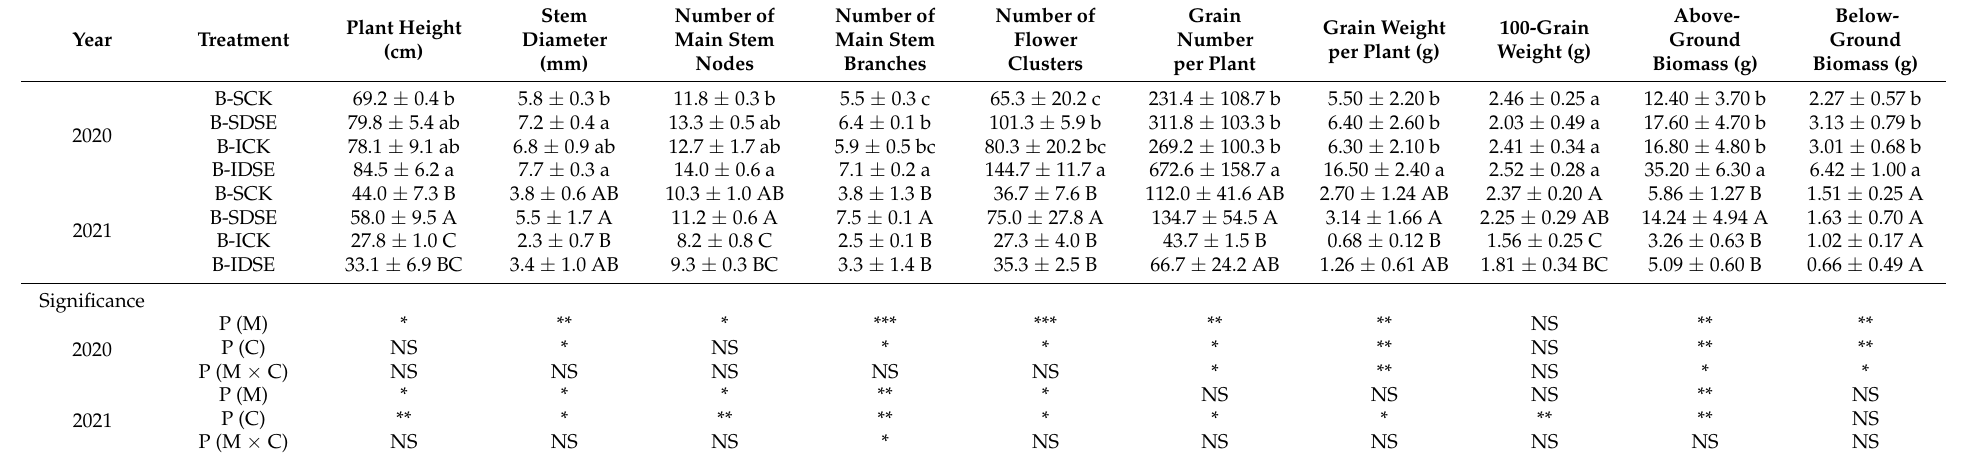
Table 1. Effects of the different treatments on the yield components of